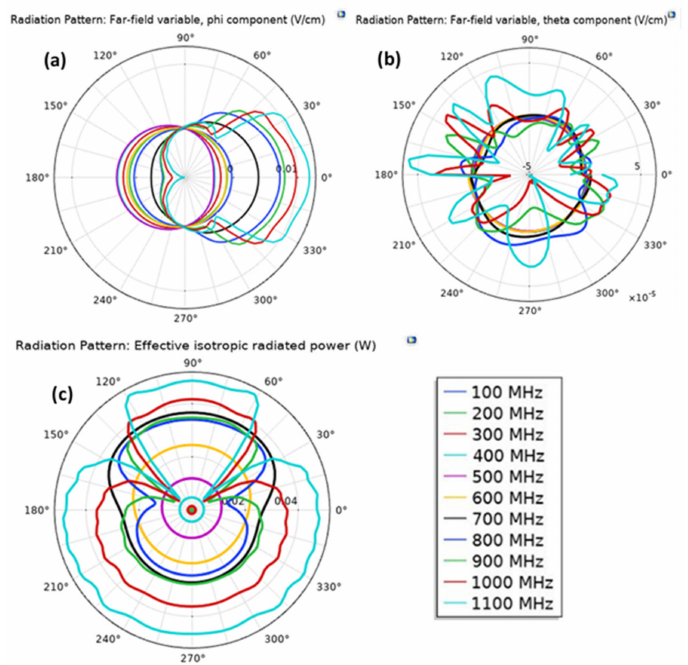
Figure 10. A two-dimensional polar plot of the far-field pattern showing ( a ) a radiation pattern along the phi component, ( b ) a radiation pattern along the theta component and ( c ) the distribution of the radiated isotropic power around the antenna.